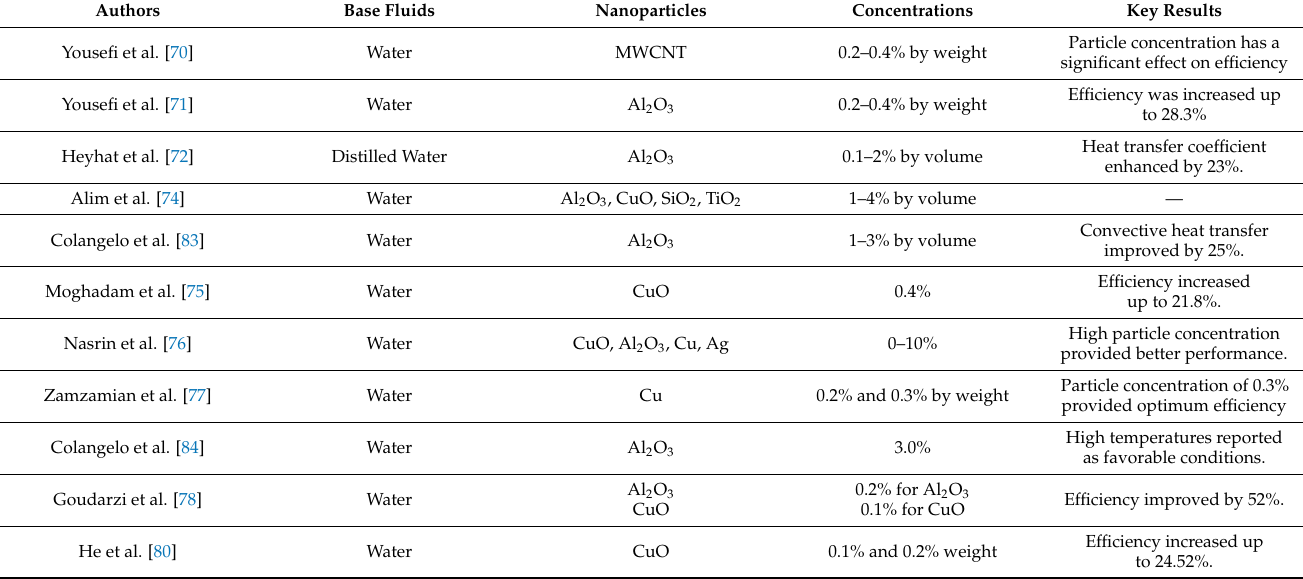
Table 4. Selective studies on